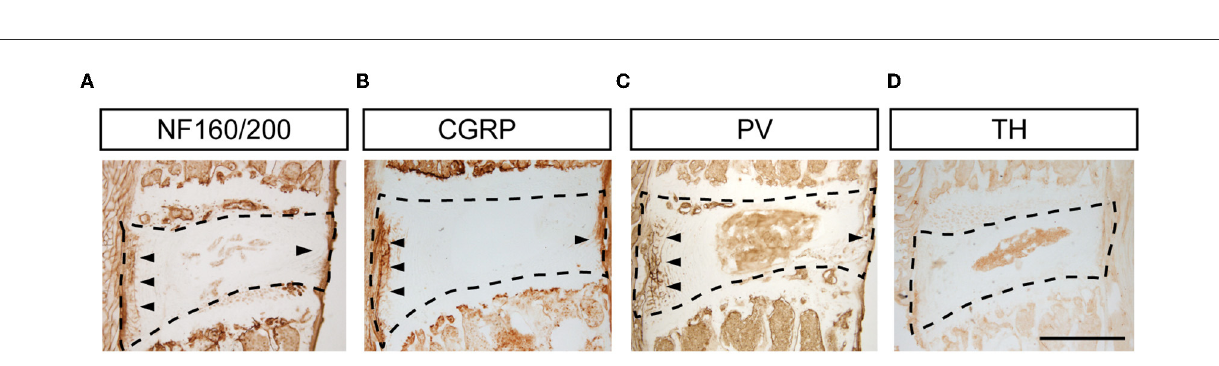
FIGURE3 Types of nerve terminals in L5/6 disk in mice. Representative images of NF160/200 + (A) , CGRP + (B) , PV + (C) , and TH + (D) staining in disks. Scale bar: 500 µ m.